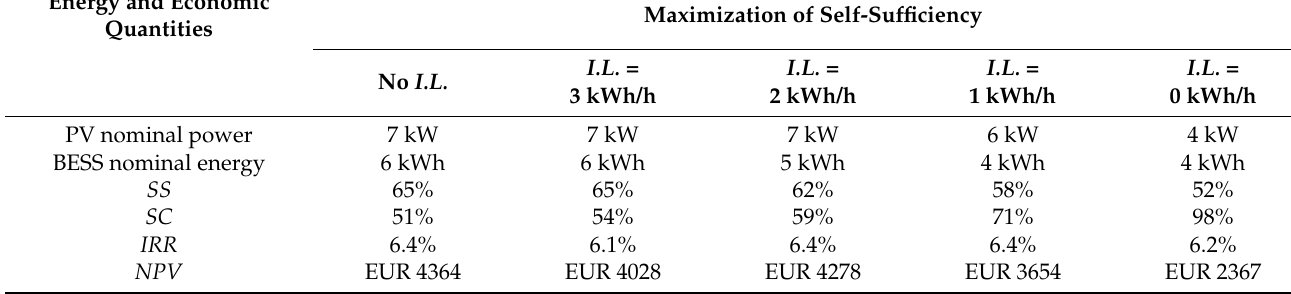
Table 4. Main results of the case with PV plant coupled to BESS. Energy and Economic